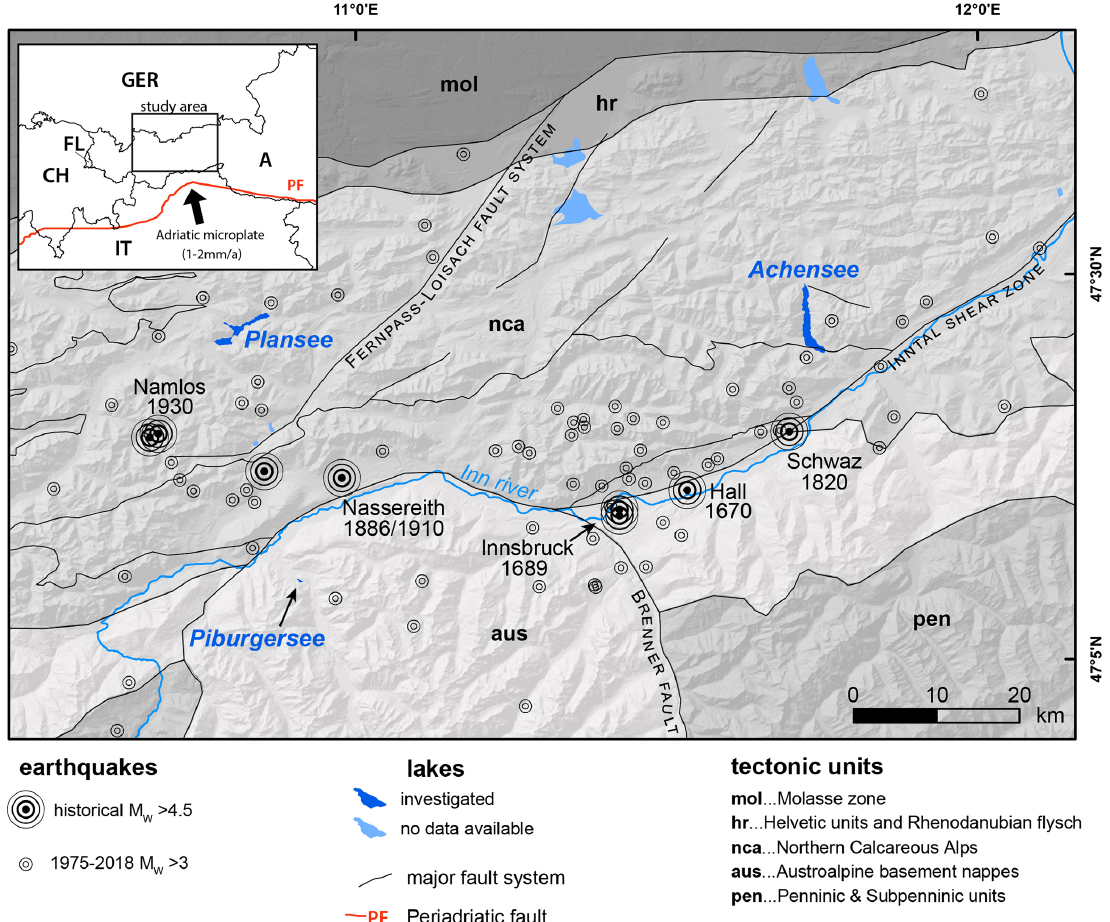
Figure 1. Overview map of the study area. The investigated lakes are located within the Northern Calcareous Alps and Austroalpine basement units subdivided and dissected by large-scale fault systems. Recent seismicity is concentrated in a 100km wide E–W-oriented zone around the Inn valley and along the Fernpass–Loisach fault system. Severe historical earthquakes are also documented in these regions. Earthquake data derived from Stucchi et al. (2013) and Reiter et al. (2018). Inset map shows northward indentation of the Adriatic microplate into the Eastern Alps delimited by the Periadriatic Fault (PF). The study area (black rectangle) is located in western Austria (A) and surrounded by Germany (GER), Italy (IT), Switzerland (CH), and Liechtenstein